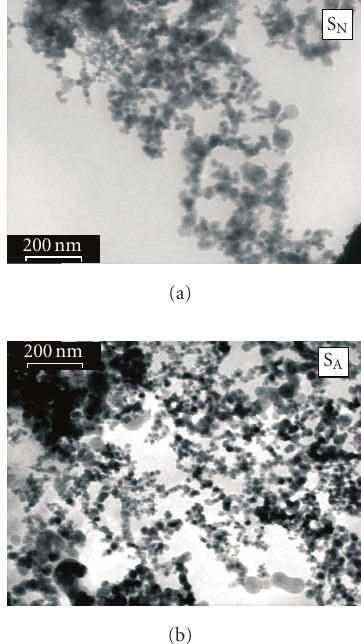
Figure 11: General TEM view of the samples S N (a) and S A